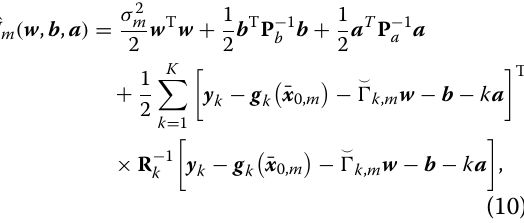
where b denotes the bias component, while a is the coef- ficient for the trend component. The bias and trend terms correspond to the offset and the linear departure in time between the observation and the model, respectively. Here, we assume that the observation is mostly explained by the dynamo model output and that the bias and trend components are minor. We thus select